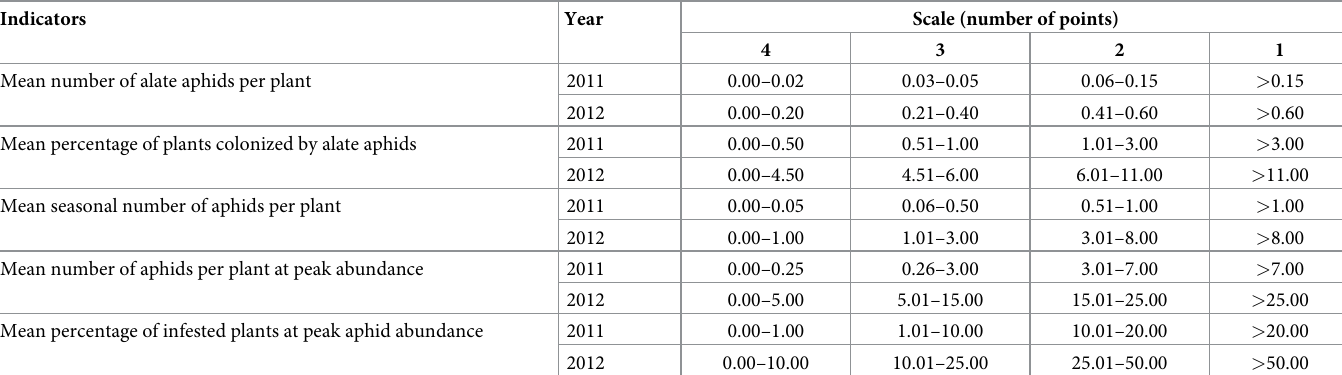
Table 1. The number of points assigned to indicators of the field resistance of carrot cultivars to the hawthorn carrot aphid, Dysaphis crataegi . Indicators